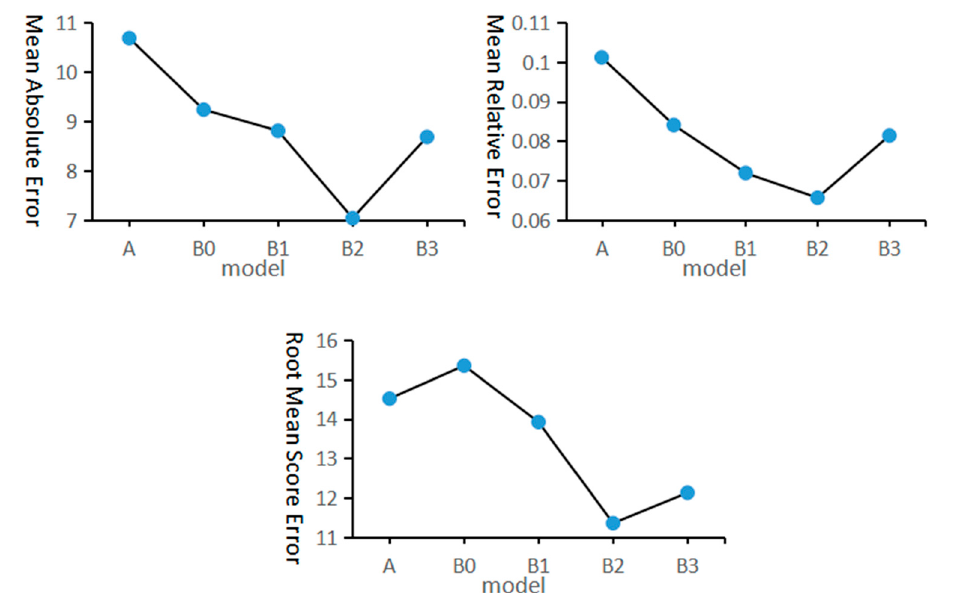
Figure 9. MAE, MRE and RMSE under various scales in Central China.